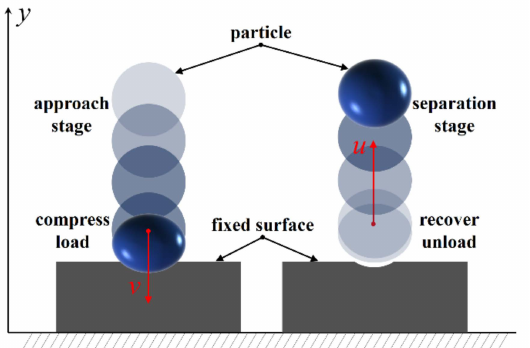
Figure 1. Analysis of collision